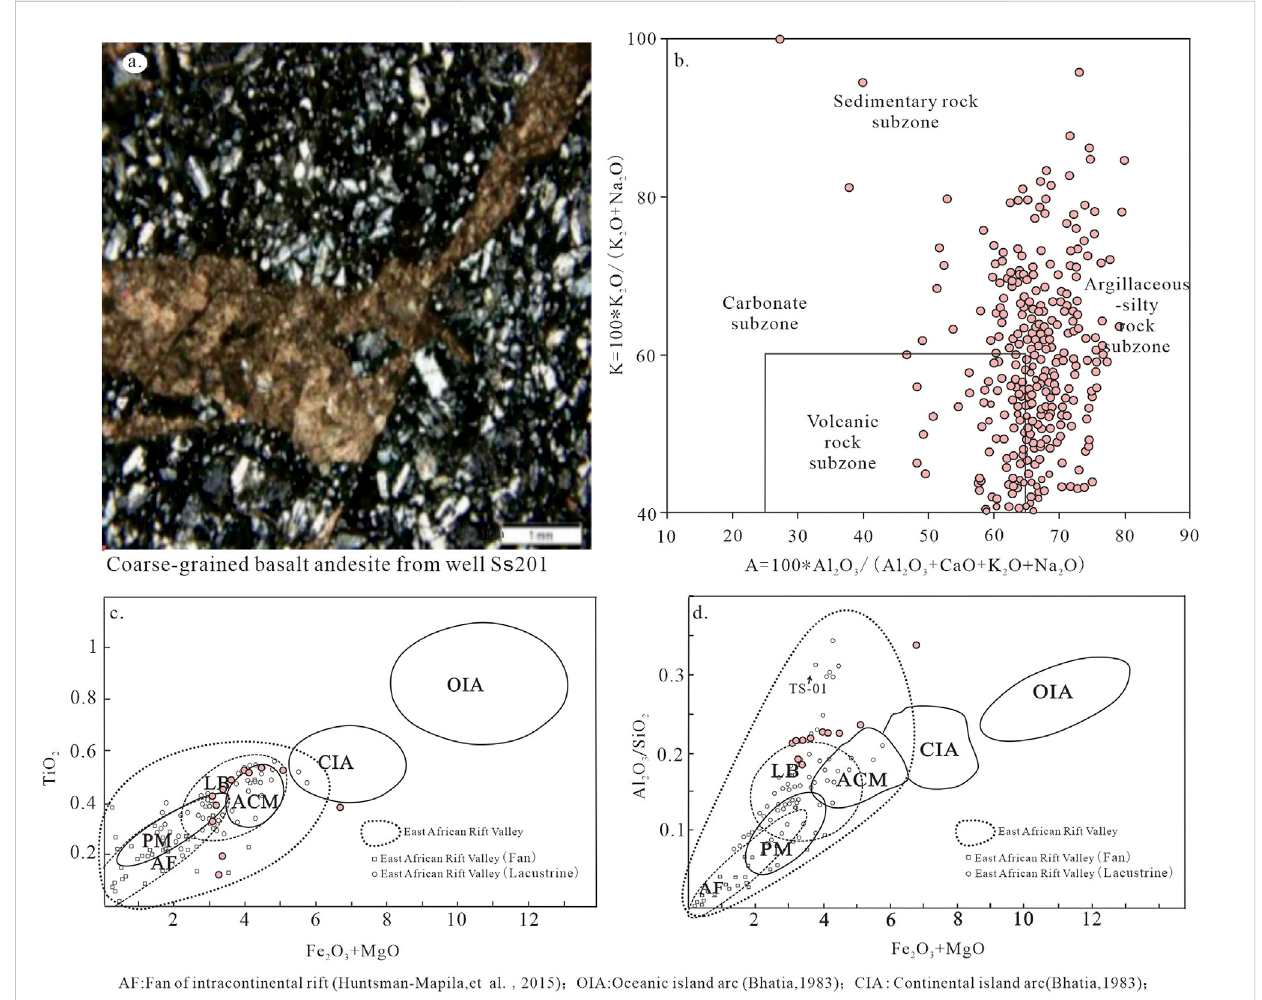
FIGURE 4 Lithologic photos and discrimination map of volcanic rocks in Songliao